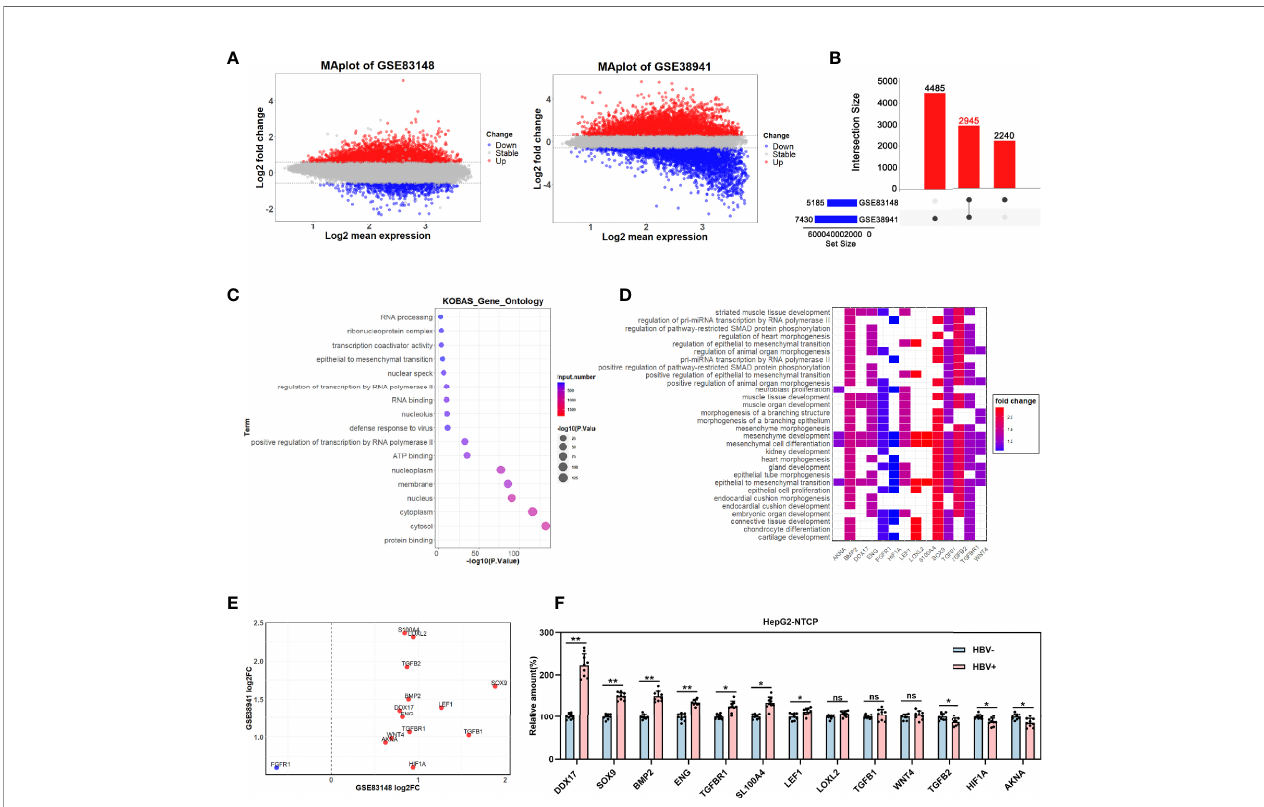
FIGURE 1 | The effect of HBV on DDX17 expression were analyzed in GEO database. (A – E) Dataset GSE83148 and GSE38941 were download from GEO database and subjected to bioinformatics analysis. (A) Volcano plots show the potential differentially expressed genes in GSE83148 and GSE38941(log2FC>0.585, adjusted p < 0.05). (B) The Venn diagrams reveal the differentially expressed genes and the co-expressed genes among the 2 cohorts (fold change value >2). (C) Functional enrichment analysis shows the co-up-regulated and co-down-regulated genes. (D) Signaling pathway analysis for 14 candidate genes. (E) Co-expression of 14 genes in GSE83148 and GSE838941. (F) Real-time PCR analysis for the 13 genes expression levels in HBV-infected HepG2-NTCP cells. b -actin was used as an internal quantitative control. ns means no signi fi cance, *P < 0.05, **P <